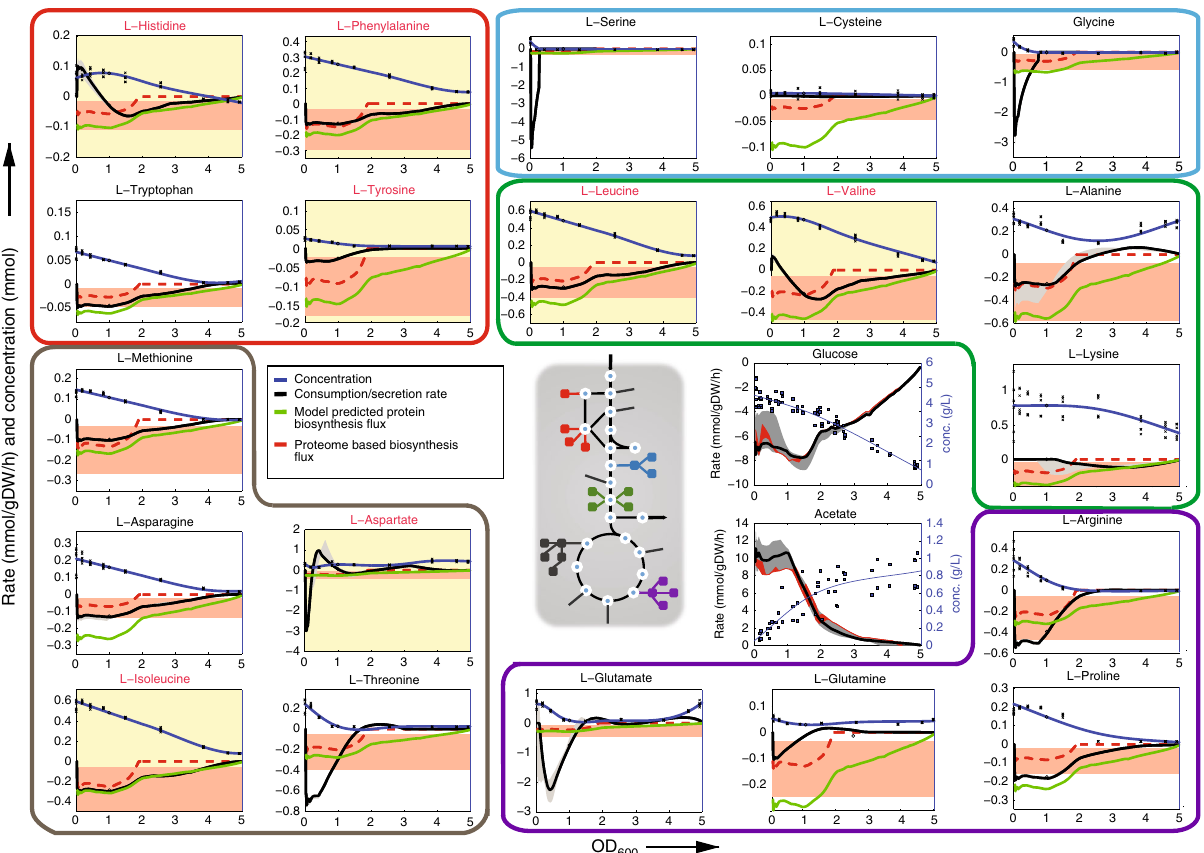
Fig. 3 Estimated rates of amino acid uptake. Measured amino acid concentrations in the supernatant (crosses) and interpolated values (blue lines). The black line represents the calculated instantaneous uptake rate, and the gray shaded region the con fi dence intervals. The fl ux requirements for protein biosynthesis (green line) was estimated from the stoichiometry of biomass composition multiplied by the instantaneous growth rate. Red shaded regions delineate lower and upper bounds of amino acid requirements for protein biosynthesis estimated from experimental measurements of protein abundance in E. coli grown in rich medium (~ 20 min doubling time) and glucose minimal medium (~ 60 min doubling time) 43 . Dashed red lines are direct linear interpolations from the upper and lower bounds multiplied by the instantaneous growth rate. The experimentally determined glucose uptake and acetate secretion rates (black line/gray region) are compared to estimates from variability analysis of constrained-based model simulations (red region). The chart backgrounds of all non-degradable amino acids are highlighted in yellow and the font color is red. Amino acids degraded into the same product are grouped by different colors, according to the central schematic metabolic